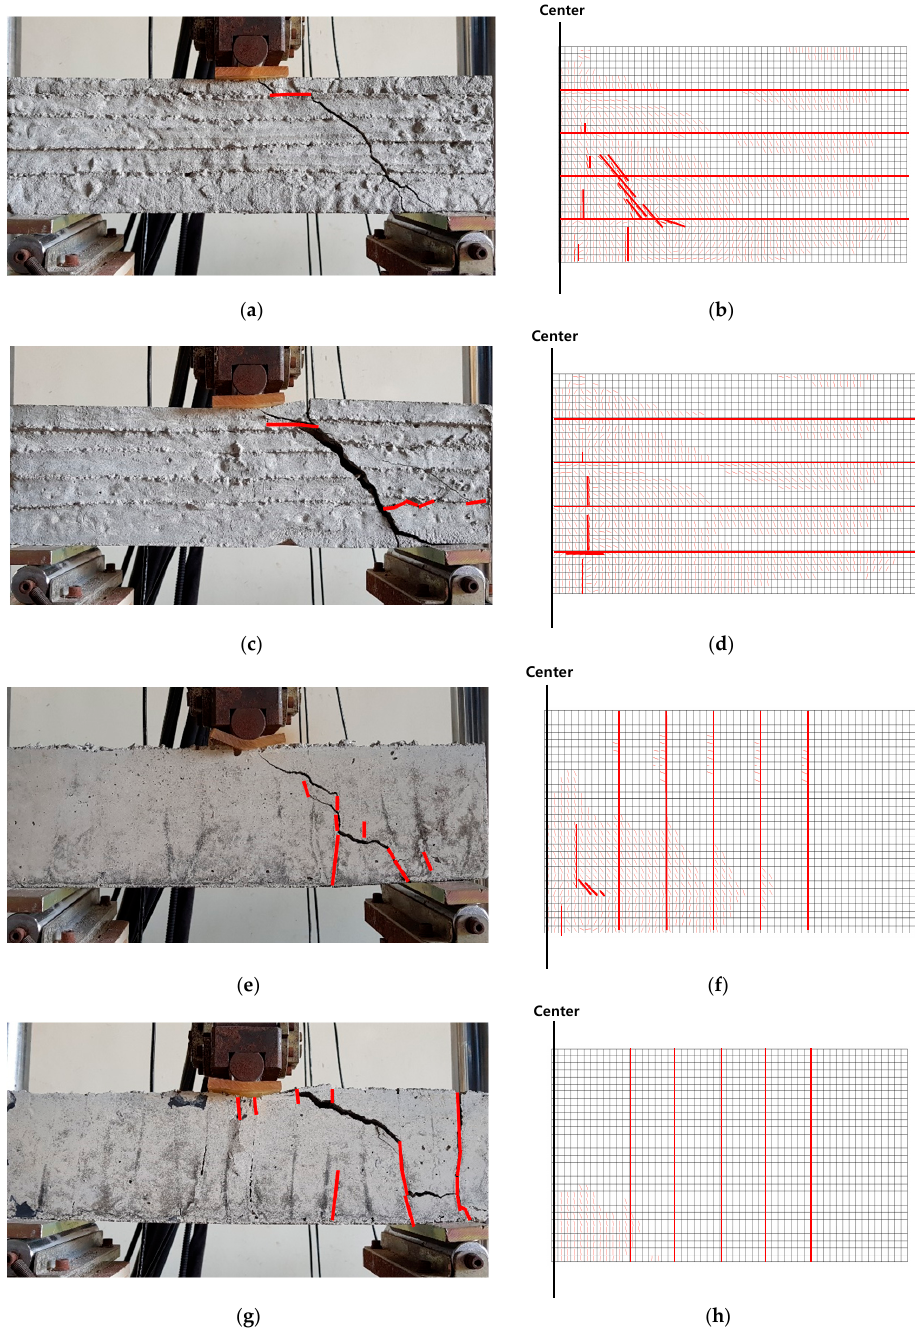
Figure 21. Crack patterns from experiments and analysis: ( a ) H-60 (experiment); ( b ) H-60 (analysis, scale 20); ( c ) H-150 (experiment); ( d ) H-150 (analysis, scale 20); ( e ) V-60 (experiment); ( f ) V-60 (analysis, scale 20); ( g ) V-150 (experiment); and ( h ) V-150 (analysis, scale 20).